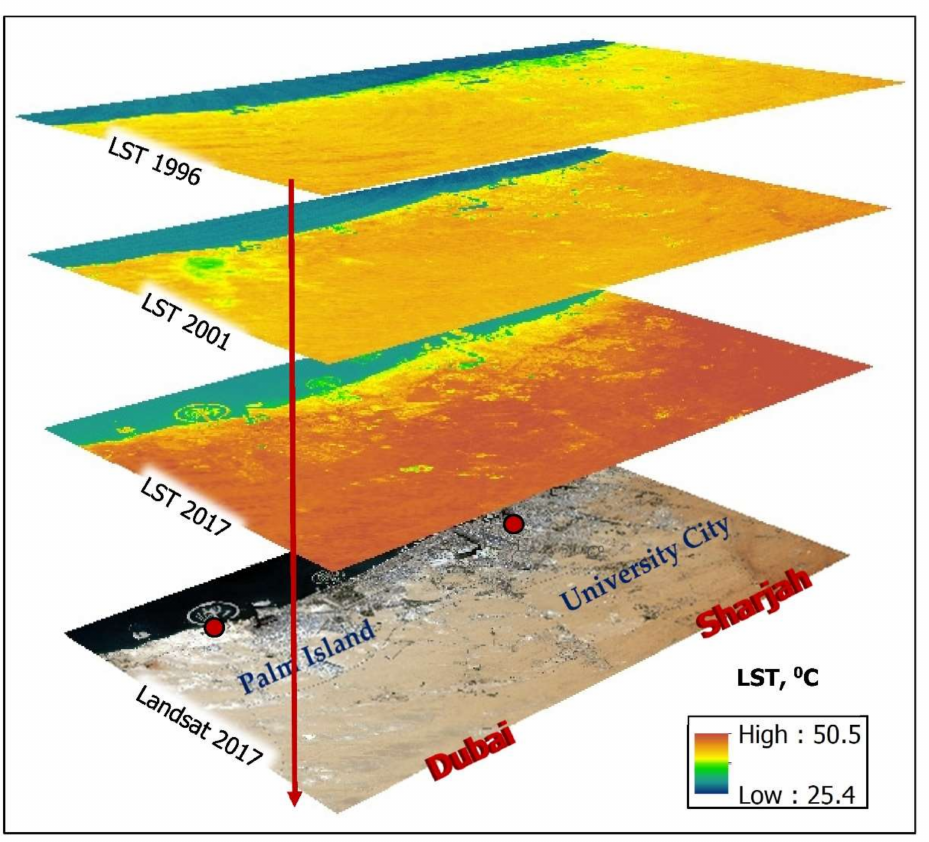
Figure 8. Three-dimensional representation of LST with Landsat